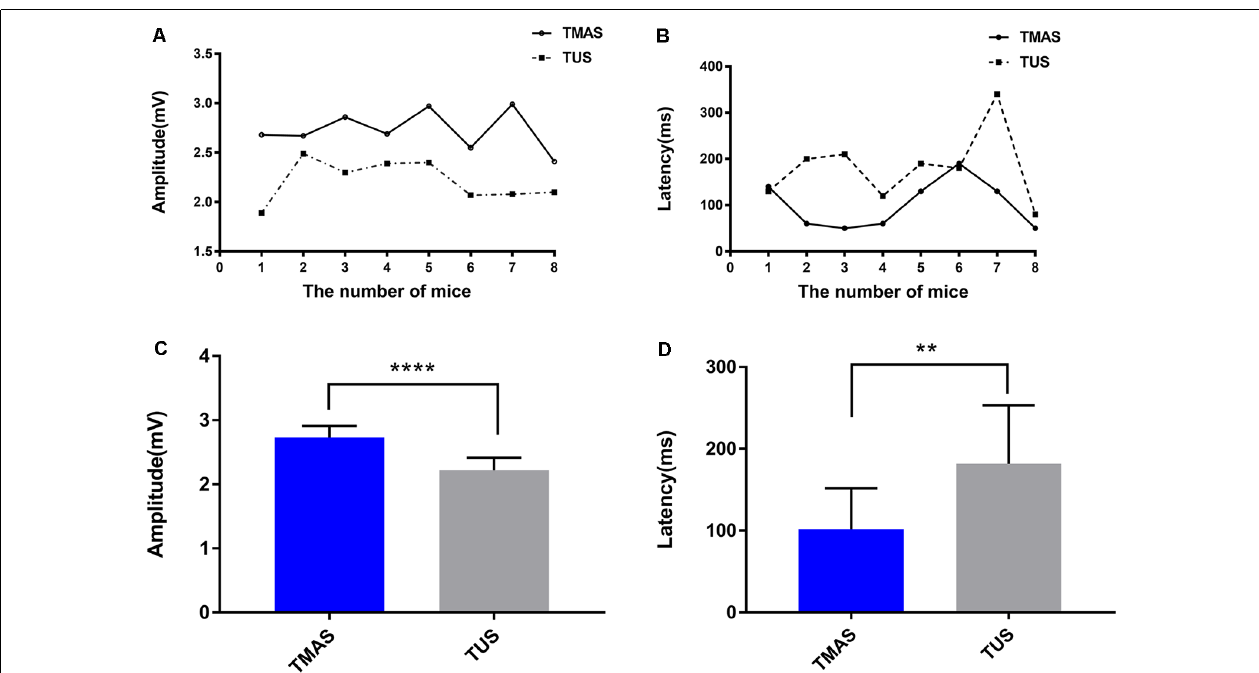
FIGURE 6 | EMG amplitude and response latency induced by TMAS and TUS. (A) The two fitted curves are the EMG amplitudes induced by TMAS and TUS at a Psptp of 83 KPa, and each dot represents the average EMG amplitude induced by TMAS in each mouse ( n = 8). Each square point represents the average value of EMG amplitude induced by TUS in each mouse ( n = 8). (B) Comparison of EMG response latency induced by TMAS and TUS. Each dot represents the average EMG amplitude induced by TMAS in each mouse ( n = 8). Each square point represents the average value of EMG amplitude induced by TUS in each mouse ( n = 8). (C) Comparison of the average amplitude of TMG induced by TMAS and TUS ( n = 8). (D) Comparison of the EMG average response latency induced by TMAS and TUS ( n = 8). ∗∗ p < 0.01, ∗∗∗∗ p <